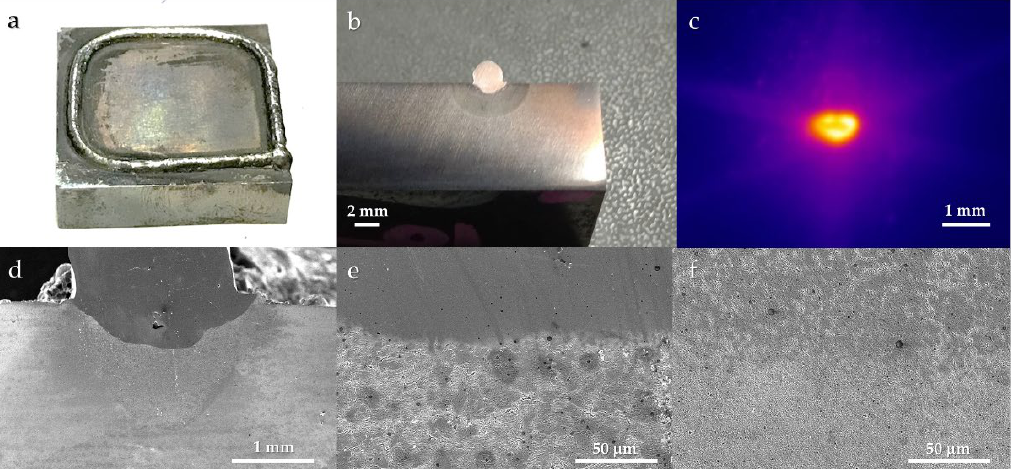
Figure 13. Laser cladding on U75V with laser power 500 W scan speed 1 mm/s with 10-layer deposition resulted in porosities. ( a ) Cladded substrate, ( b ) substrate’s cross-section, ( c ) IR image during laser cladding, ( d , e ) SEM images at the interface region and ( f ) SEM at the HAZ region.